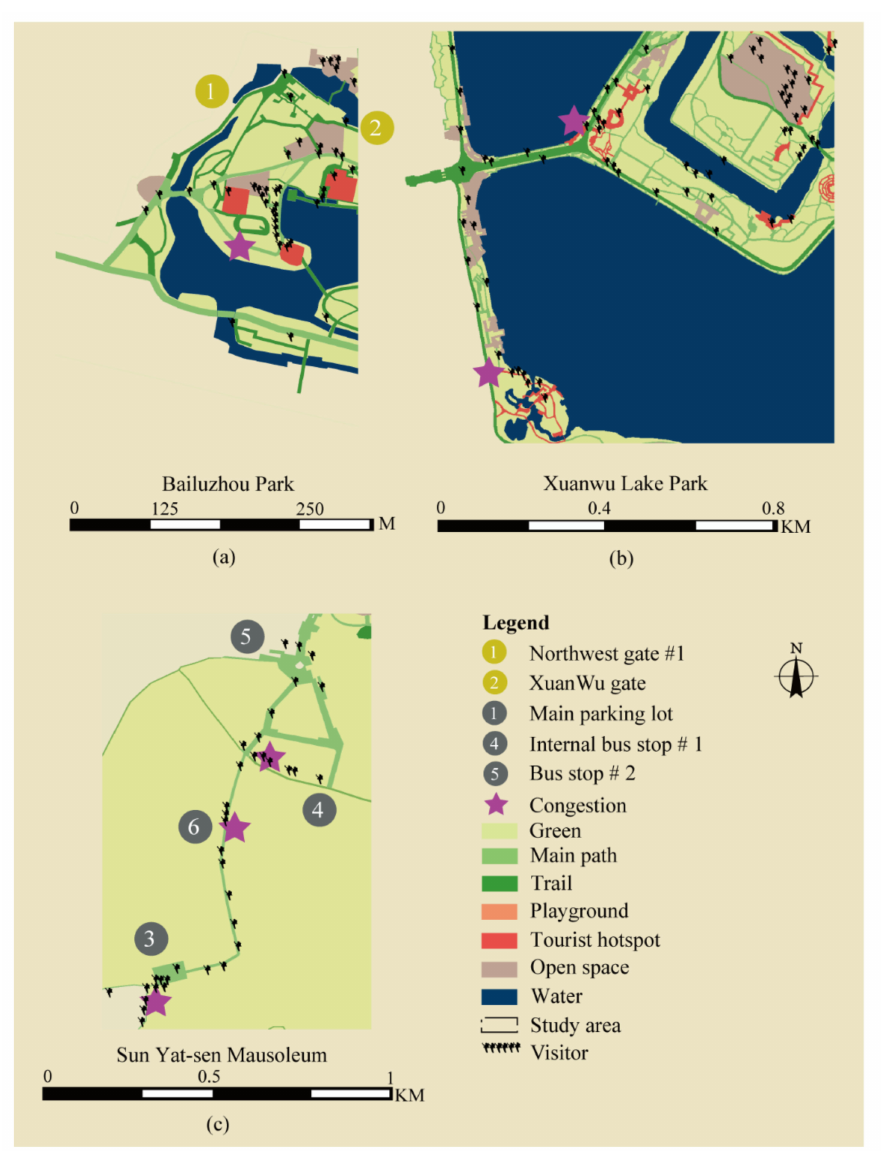
Figure 6. Congestion points in parks. The tiny human shape figure in maps represents a single visitor. Black stars display places of congestion. ( a ) is the map of congestion in Bailuzhou Park. The congestion is on a trail between two destinations. ( b ) is the map of congestions in Xuanwu Lake Park. The congestions are inside trails in the destinations. ( c ) is the map of congestions in Sun Yat-sen Mausoleum. The congestions are near the parking area and on the long trail to the